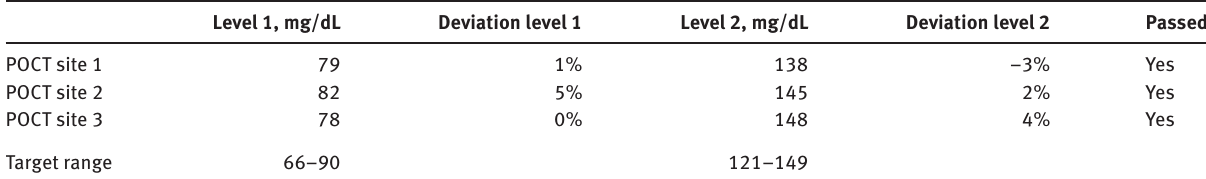
Table 4: Results of the simulated eIQC test on three different POCT